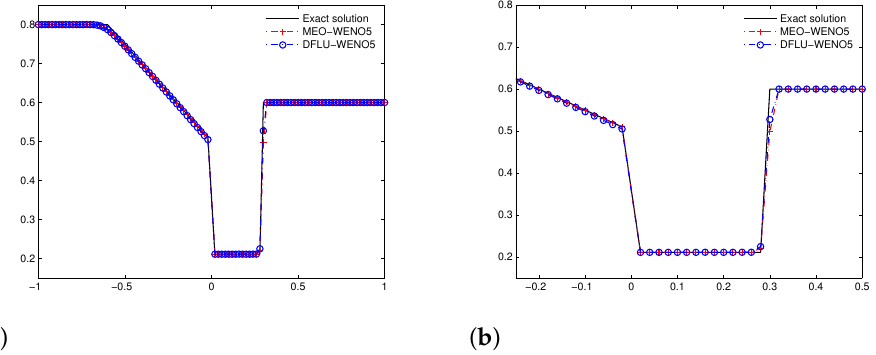
Figure 5. Example 1 computed by the MEO-WENO5 and DFLU-WENO5 with ∆ x = 1/50. ( a ): the numerical and exact solutions; ( b ): the numerical and exact solutions zoomed in.